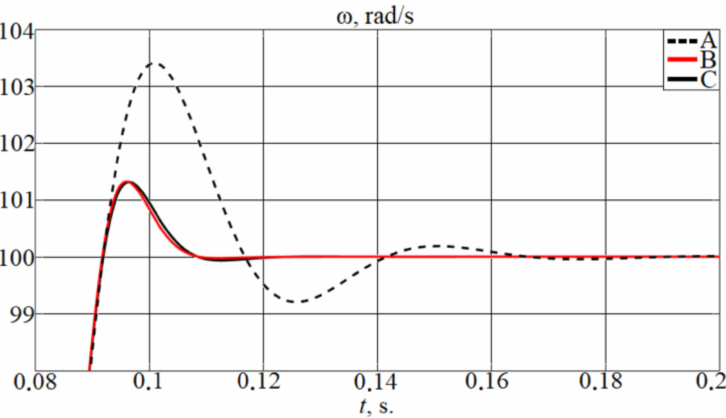
Figure 9. Comparison of transients of motor speed when τ e (cid:54) = 0, ˆ K ref ( 0 ) − K ref (cid:54) = 0 and ˆ K ( 0 ) − K (cid:54) = 0. The transient curves of in Figure 10 (the ideal values were calculated using (27)).